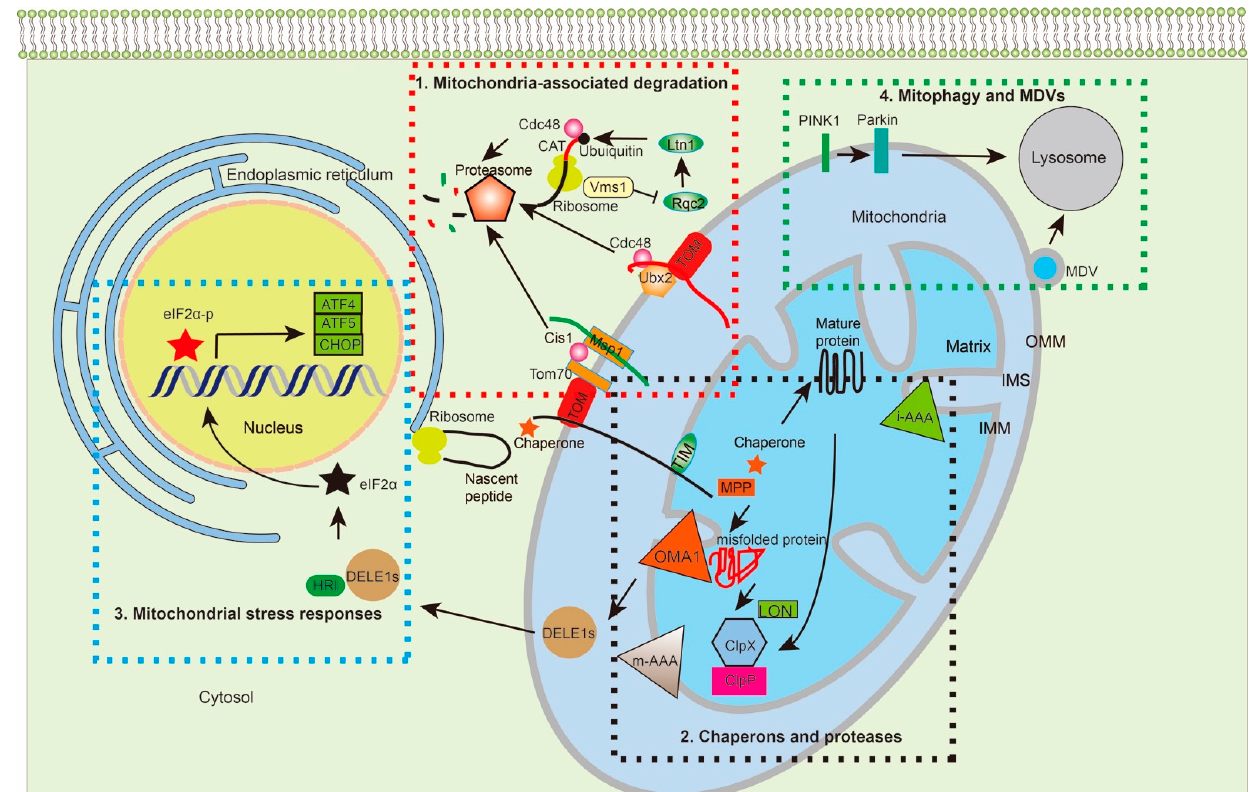
Figure 2. Multiple MPQC pathways surveil protein synthesis, import, folding, assembly, and degradation. The MPQC surveillance system can be divided into four pathways based on studies from yeast and humans: 1. Translocation-associated protein degradation. Under standard culture conditions of yeast, Ubx2 recruits Cdc48 to the TOM complex to target prematurely folded, misfolded, or clogged proteins for proteasome-mediated degradation. Under stress conditions, the cytosolic protein Cis1 links